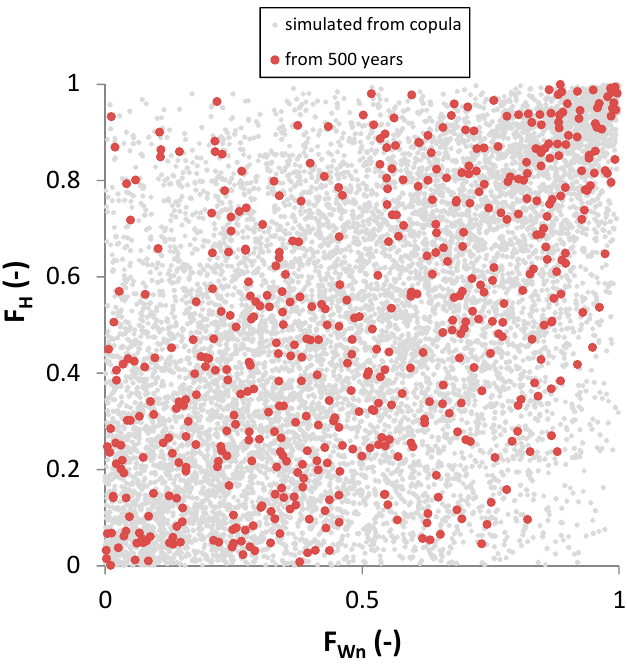
Figure 7. Comparison among pairs of CDF ( F W and 10,000 pairs of CDF generated with the Monte Carlo method by the assumed bivariate distribution.